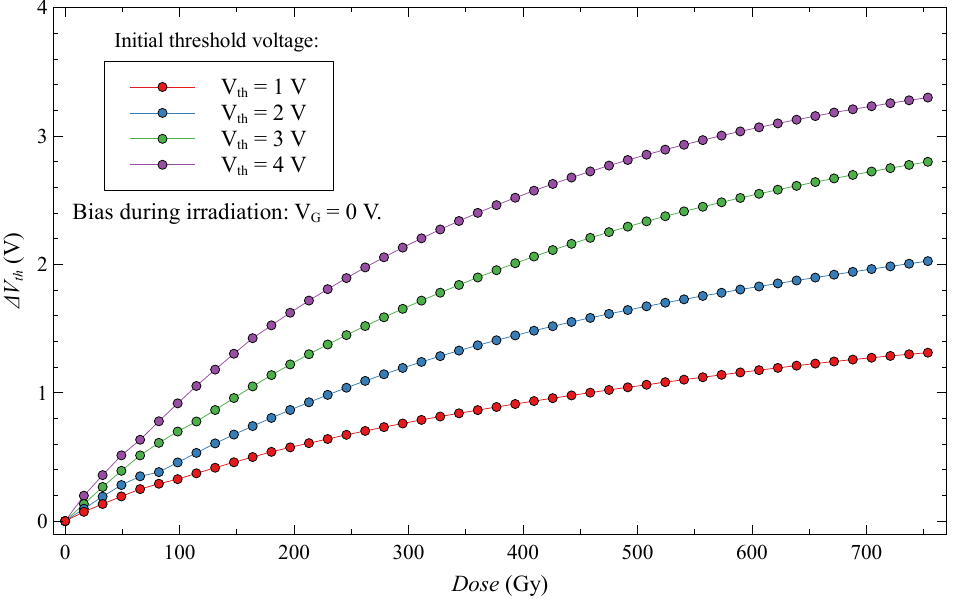
Figure 14. Threshold voltage shift for EPADs with zero bias during irradiation.